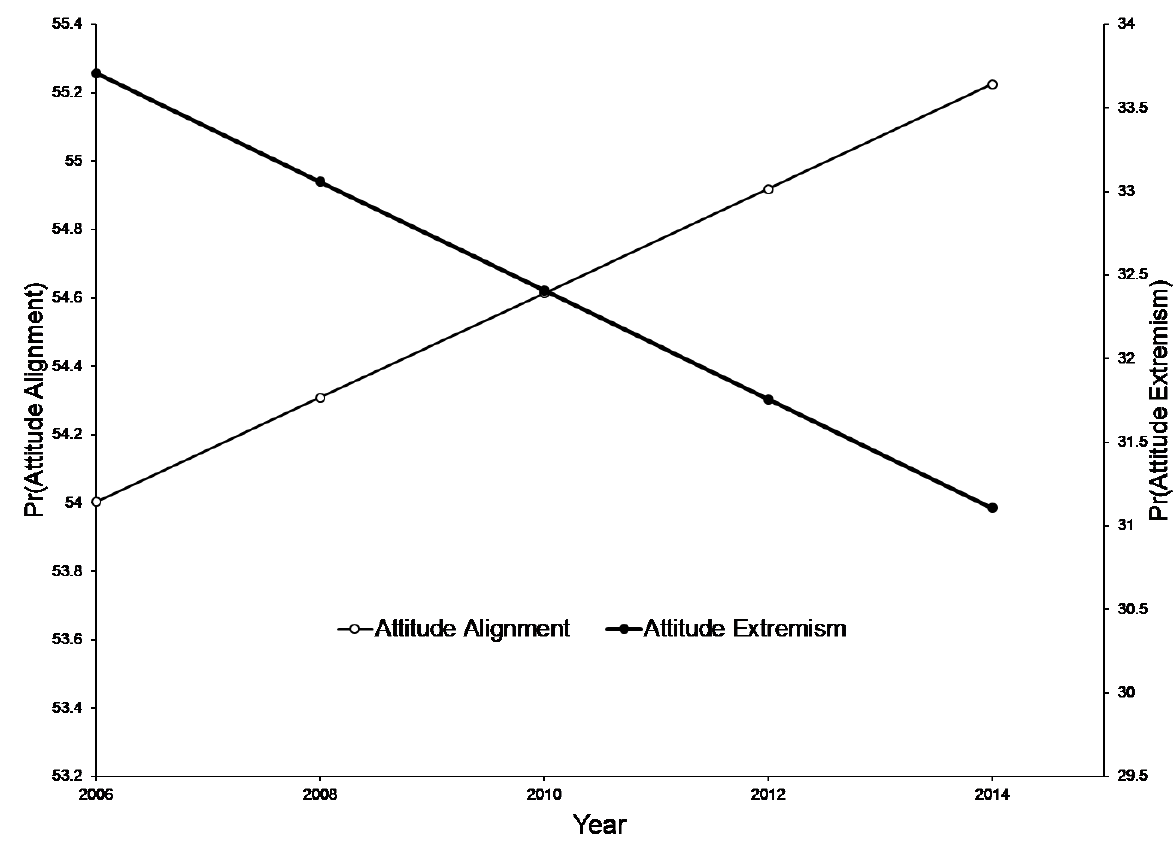
Figure 7: Predicted shifts in ideological attitude structures for liberal respondents: GSS panel data, 2006 to